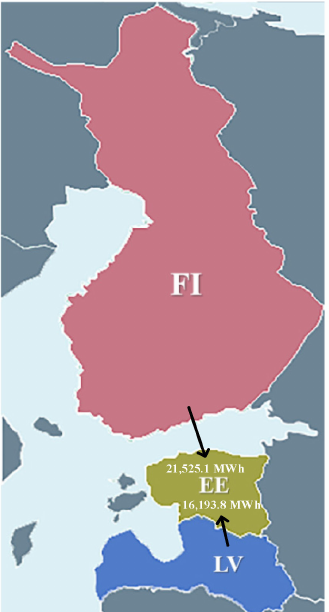
Figure 11. Geographical location of the three price areas, FI, EE, and LV.